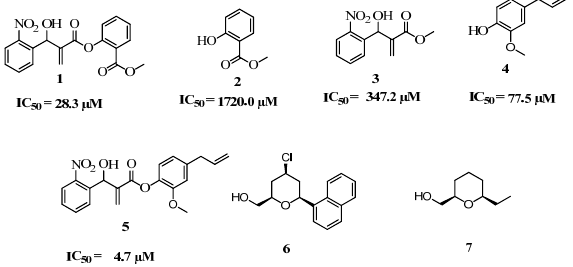
Figure 1. The leishmanicidal activity of hybrids 1 and 5 and their precursors. The analgesic/anti- inflammatory 6 and 7 .